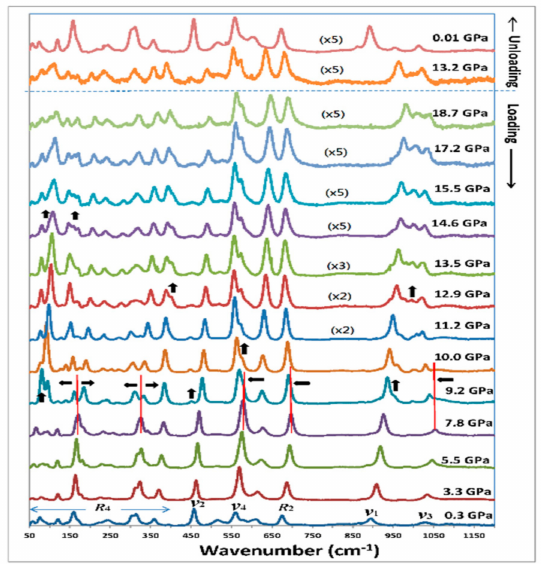
Figure 1. A series of Raman spectra of scottyite showing the effect of pressure on the Raman modes. The ν 1 and ν 4 mode is the more intense Raman modes in scottyite. The distinct peak (new peak) is marked “ ↑ ”. Arrows ( ← , → ) indicate the direction of peak movement.